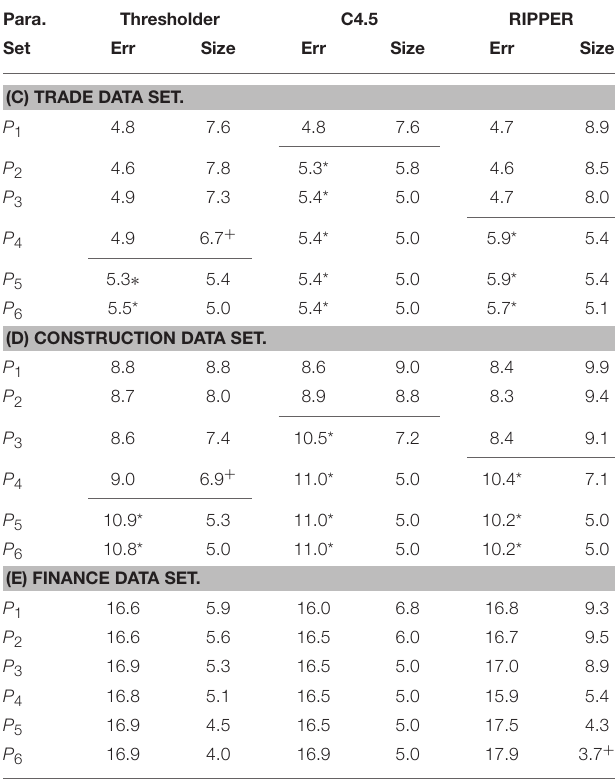
bigger than the smallest model. For the trade data set, Thresholder and C4.5 models are significantly smaller